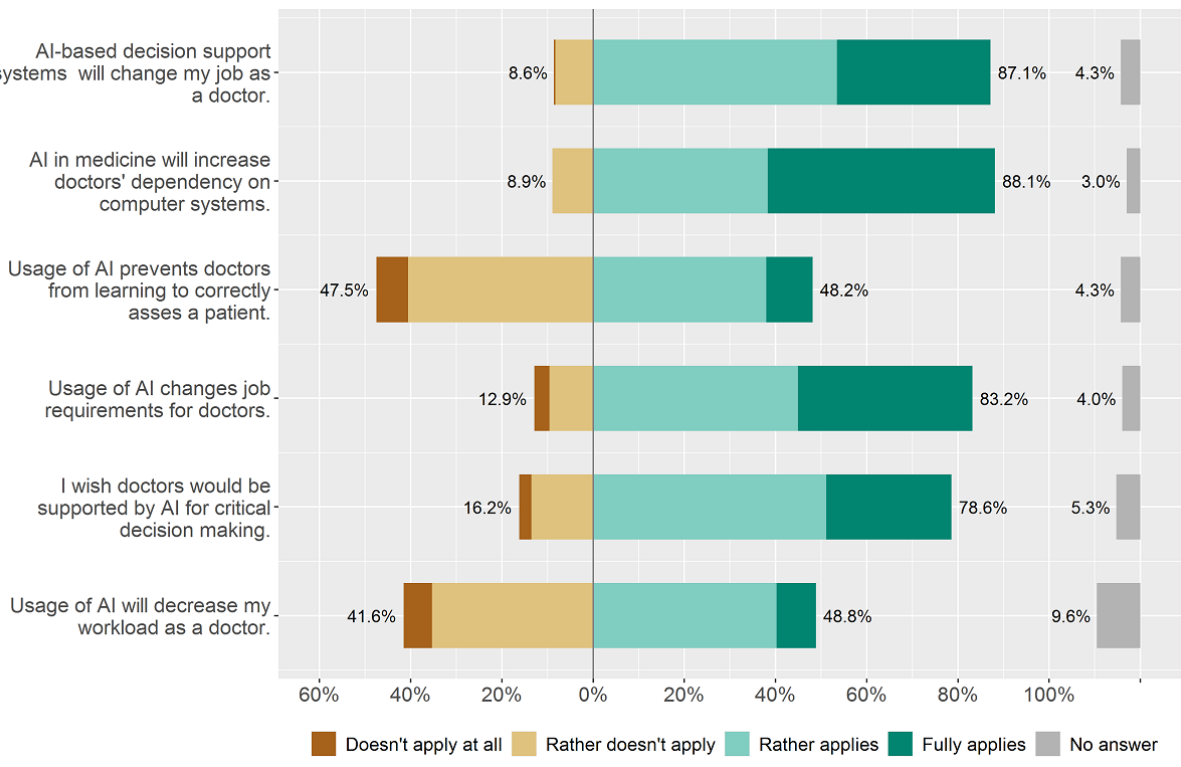
Figure 3. Effect of artificial intelligence (AI) on